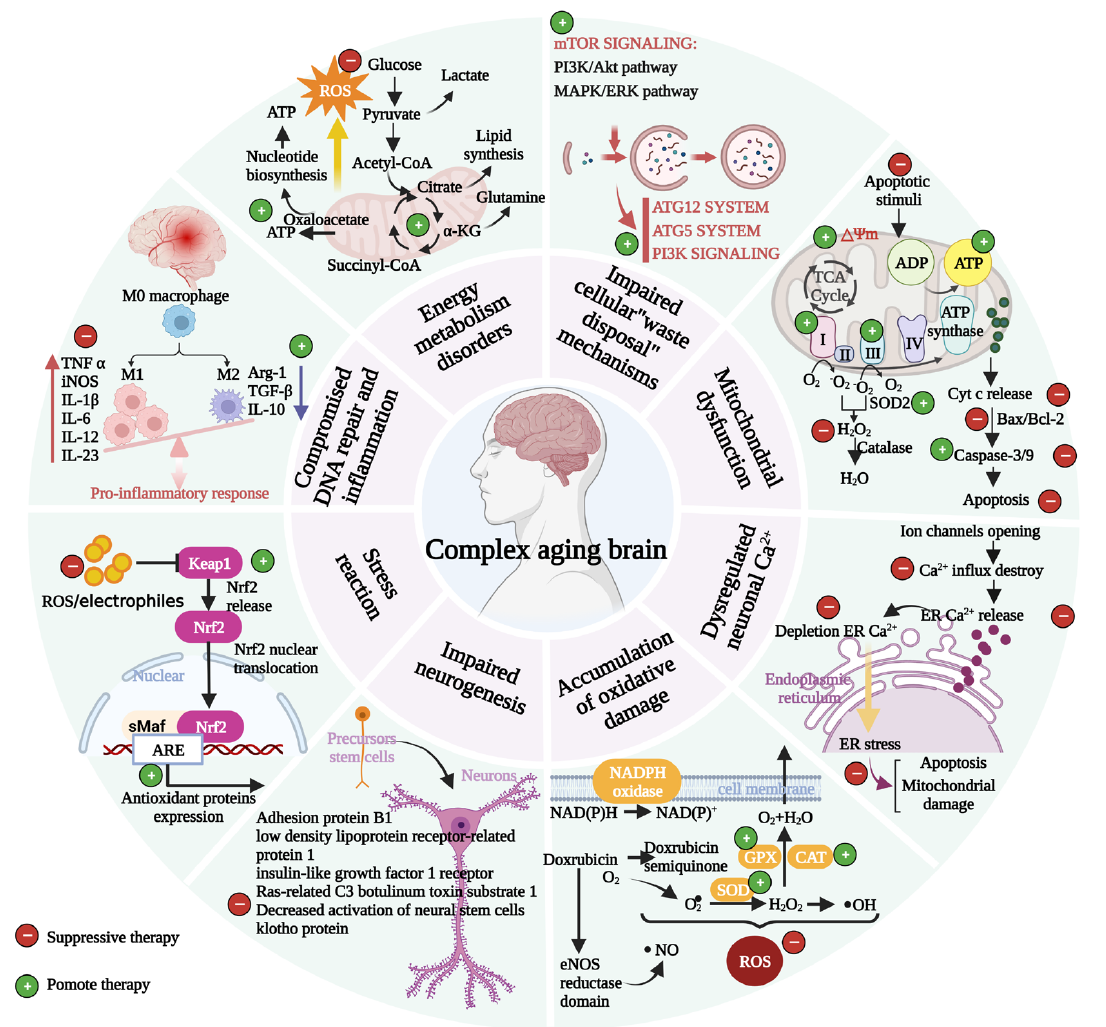
Figure 2. Intervention strategies for herbal/natural compounds based on brain aging characteristics. In the aging state, multiple mechanisms are impaired due to oxidative stress and impaired stress responses, leading to the accumulation of brain waste, mitochondrial dysfunction, dysregulation of energy metabolism, impaired DNA repair, and inflammation. Included is a brief list of targets and alterations produced by herbal or natural compound interventions. Green circles represent promotive effects and red circles represent inhibitory effects. Keap1: kelch-like ECH-associated protein-1; Nrf2: nuclear regulatory factor 2; ARE: antioxidant response element; NADPH: reduced form of nicotinamide-adenine dinucleotide phosphate; eNOS: endothelial nitric oxide synthase; ER: endoplasmic reticulum; Bax: BCL2-Associated X; Bcl-2: B-cell lymphoma-2; ATP: adenosine triphosphate; ADP: adenosine diphosphate; mTOR: mammalian target of rapamycin; ATG5, 12: autophagy-related proteins 5, 12; PI3K: phosphatidylinositol 3-kinase; Akt: protein kinase B; MAPK: mitogen-activated protein kinase; ERK: extracellular signal-regulated kinase; ROS: reactive oxygen species; M0, M1, M2: microglia resting state, pro-inflammatory cells, anti-inflammatory cells; IL-1 β or 6, 10, 12, 13: interleukins-1 β or 6, 10, 12, 13; TNF α : tumor necrosis factor α ; Arg-1: Arginase-1; TGF- β : transforming growth factor- β ; ∆Ψ m: mitochondrial membrane potential symbol; I, II, III, and IV: mitochondrial respiratory chain complex, ubiquinone oxidoreductase, succinate dehydrogenase, cytochrome c oxidase, cytochrome c reductase, respectively.